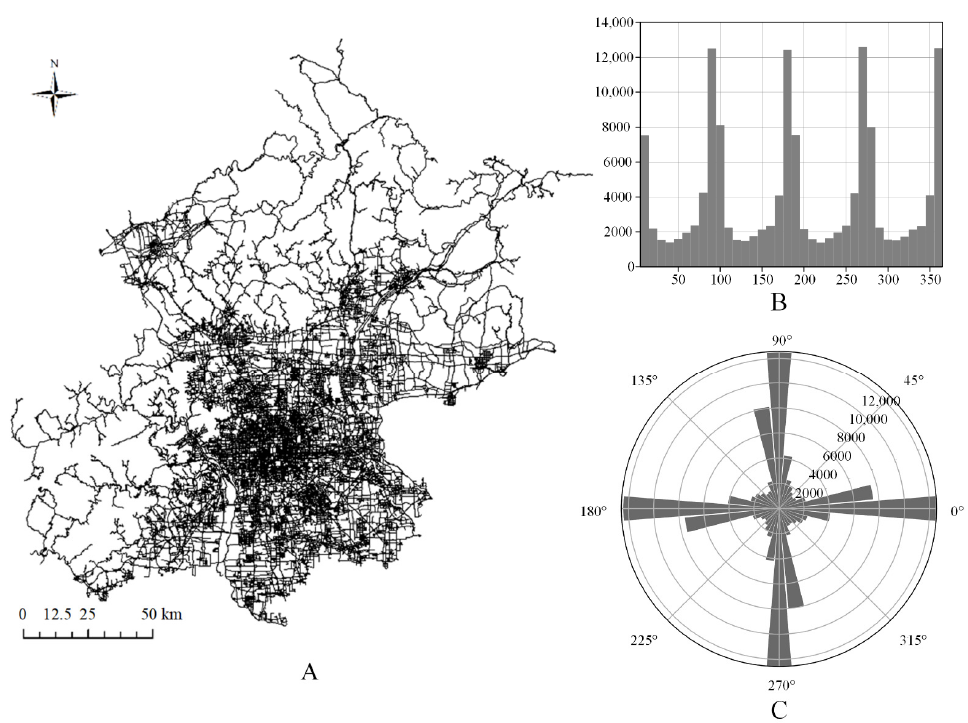
Figure 2. ( A ) Street network in Beijing. ( B ) Street orientation histogram of Beijing, where the horizontal coordinates indicate the orientation angles, and the vertical coordinates indicate the frequency of a street falling into the corresponding bin. ( C ) Street orientation rose illustration of Beijing, where the outer side of the circle represents the street orientation, and the inner data are the same as the vertical coordinate in ( B ).